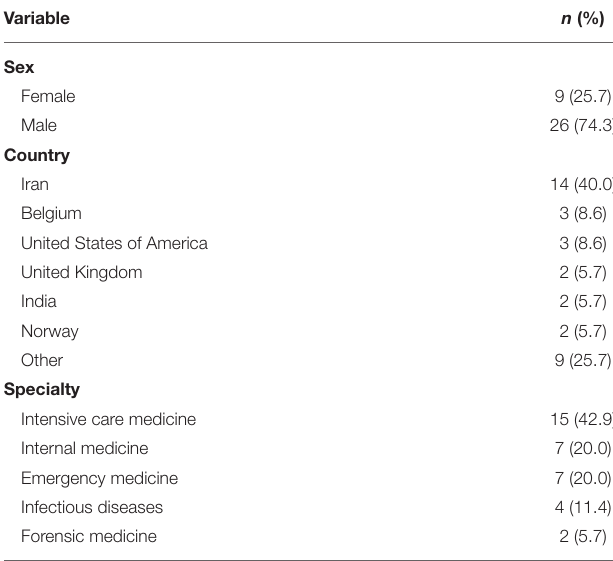
TABLE 1 | Sociodemographic characteristics of